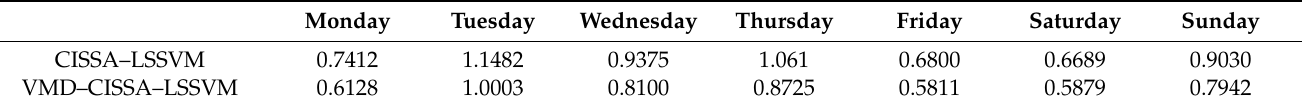
Table 7. Comparison of VMD–CISSA–LSSVM’s and CISSA–LSSVM’s predicted performance